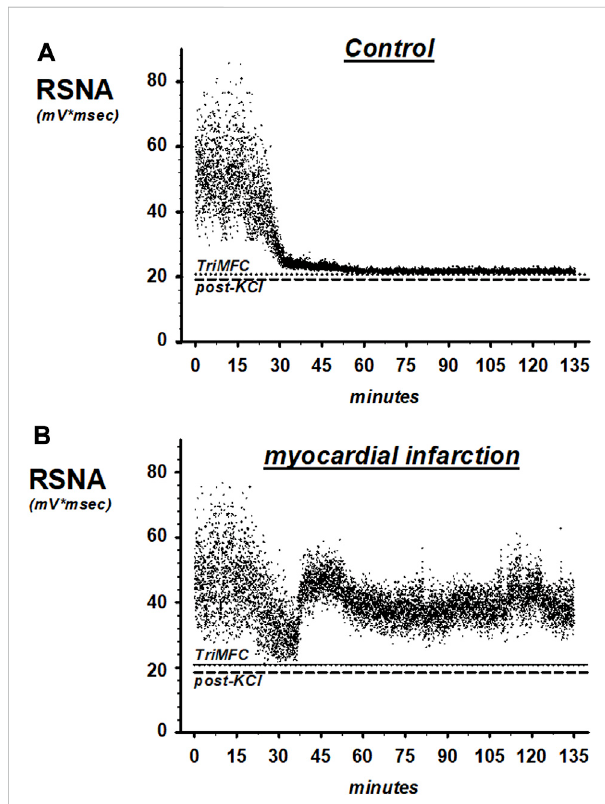
FIGURE 6 Representative recordings of renal sympathetic nerve activity (RSNA) in SHAM controls (A) and rats with myocardial infarction (B) . TrimMFC with dotted line represents the noise level after the administration of the ganglionic-blocking agent trimetapham- camsylate and post-KCL with dashed line after injecting potassium- chloride at the end of the